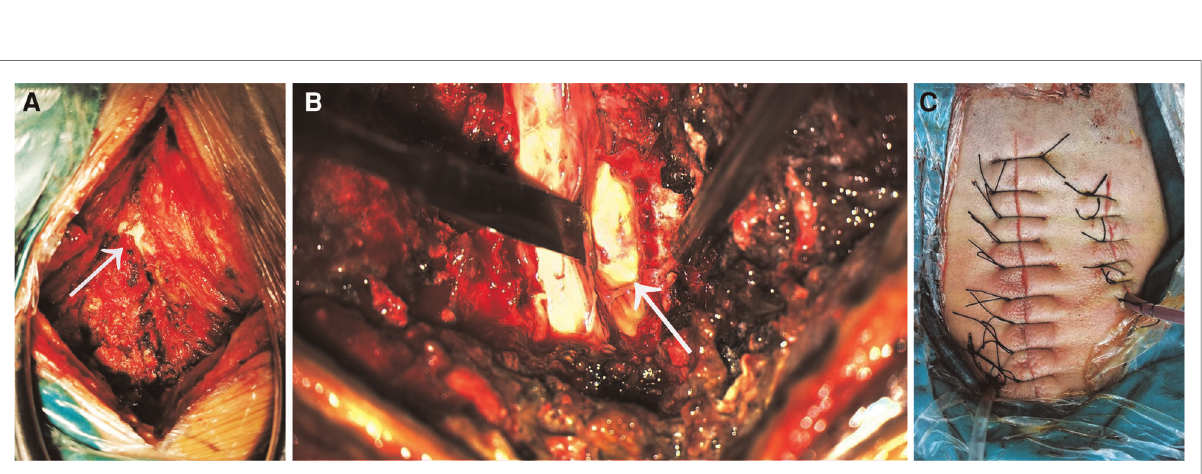
FIGURE 2 ( A ) during the operation, a fi stula was seen in the right posterior side of the spinal canal, connecting the paravertebral abscess and the spinal epidural abscess.The arrow points to the location of the fi stula. ( B ) After opening the lamina, a large amount of pus was seen in the spinal canal, and the pus was mainly located in the back of the spinal cord and the right side of the spinal cord. The arrow points to the pus on the side of the spinal cord. ( C ) The surgical incision and drainage tube for the spinal abscess are shown on the left, and the surgical incision and drainage tube for the paravertebral soft tissue abscess in the neck are shown on the